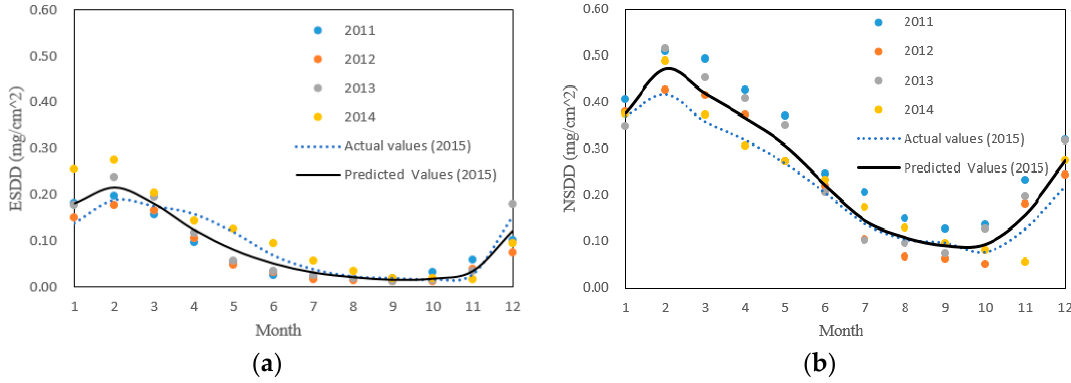
Figure 5. Comparison of predicted values ( a ) ESDD and actual values ( b ) NSDD in 2015 (He-Yun